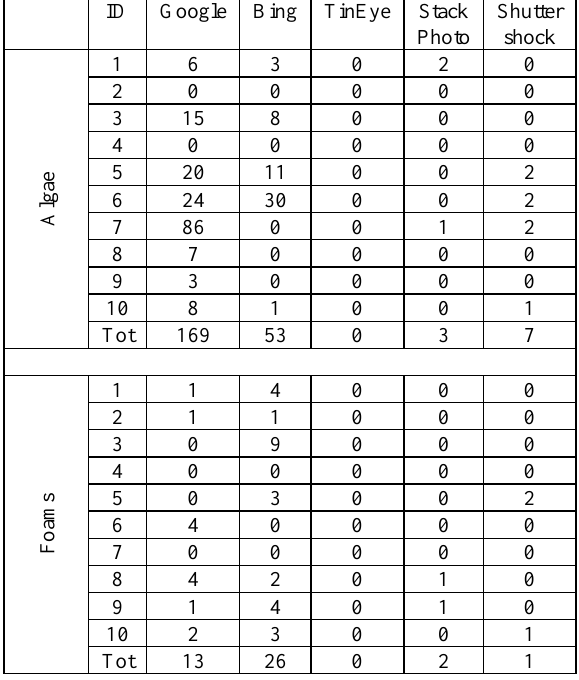
Table 1 . Valid images for the different search engines used for the search by